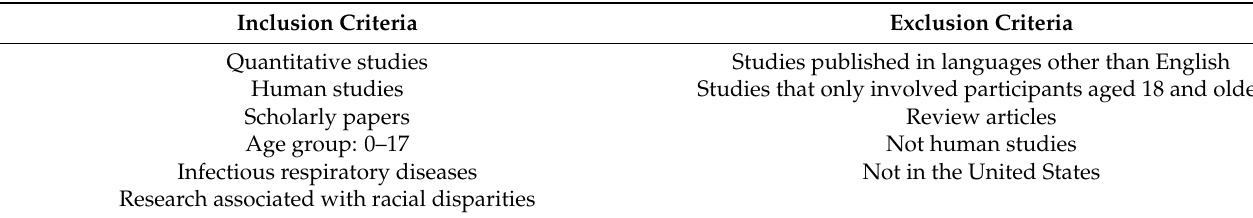
Table 1. Inclusion and exclusion criteria.